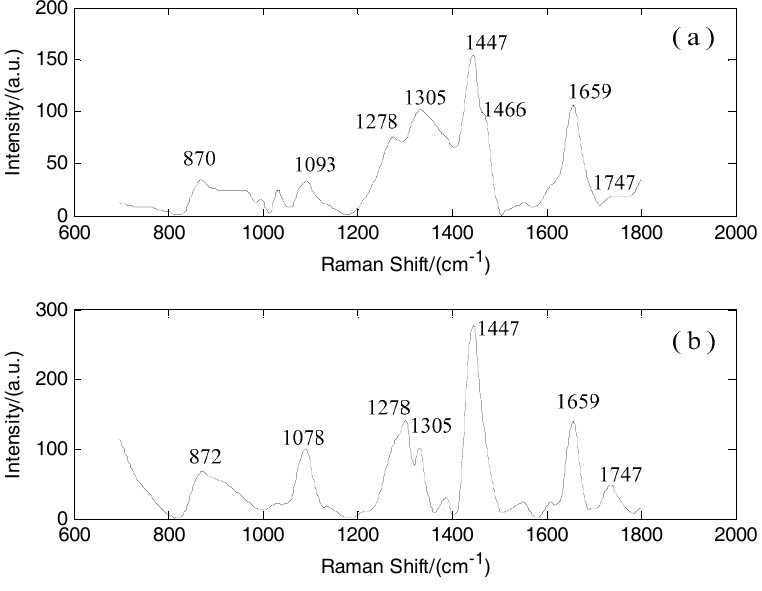
Figure 3. ( a ) Raman spectrum of breast cancerous tissues after preprocessing; ( b ) Raman spectrum of breast normal tissues after preprocessing.